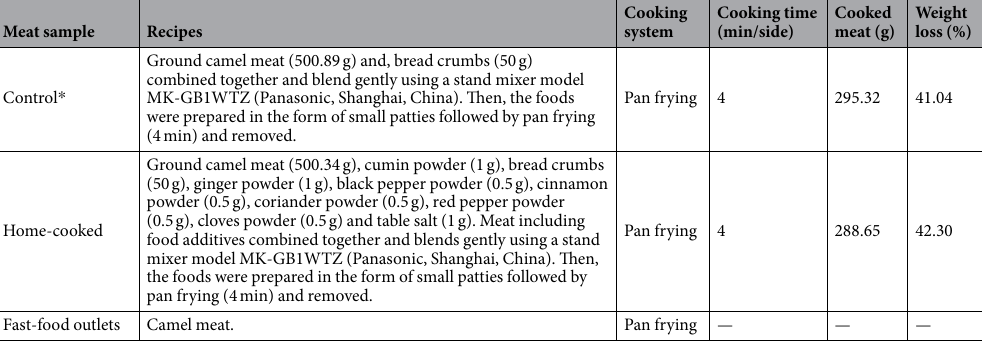
Table 3. Description of camel meat burger preparation. * Meat products cooked without food additives; —not Sample cooking conditions. Twenty camel meat burger samples were obtained from various local fast-food